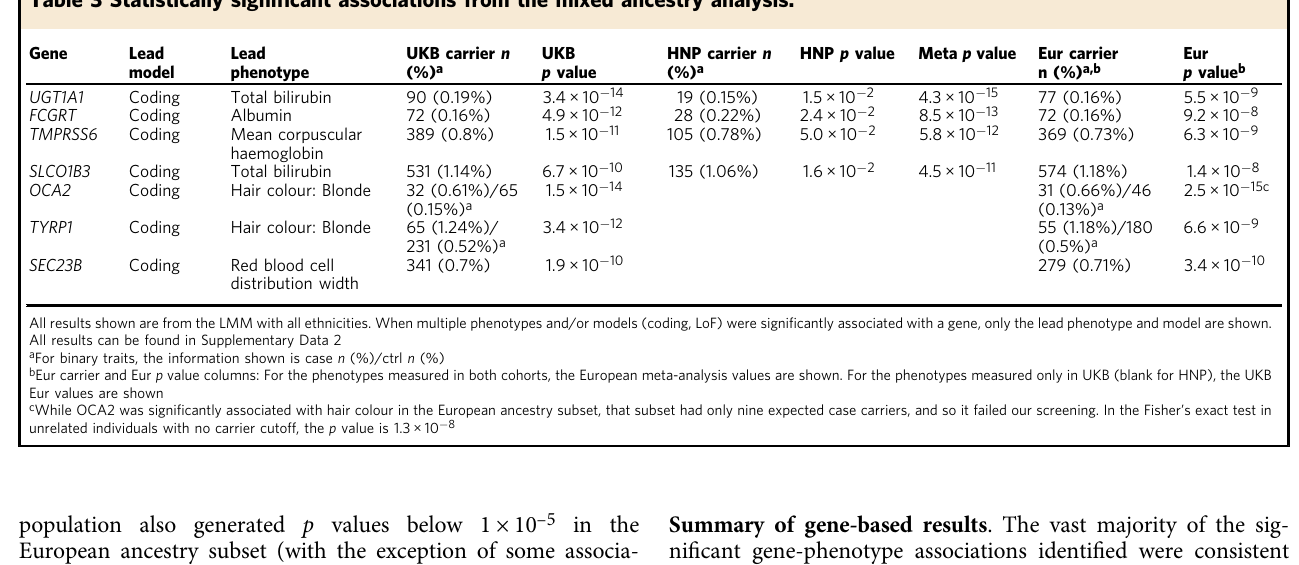
Table 3 Statistically signi fi cant associations from the mixed ancestry analysis.